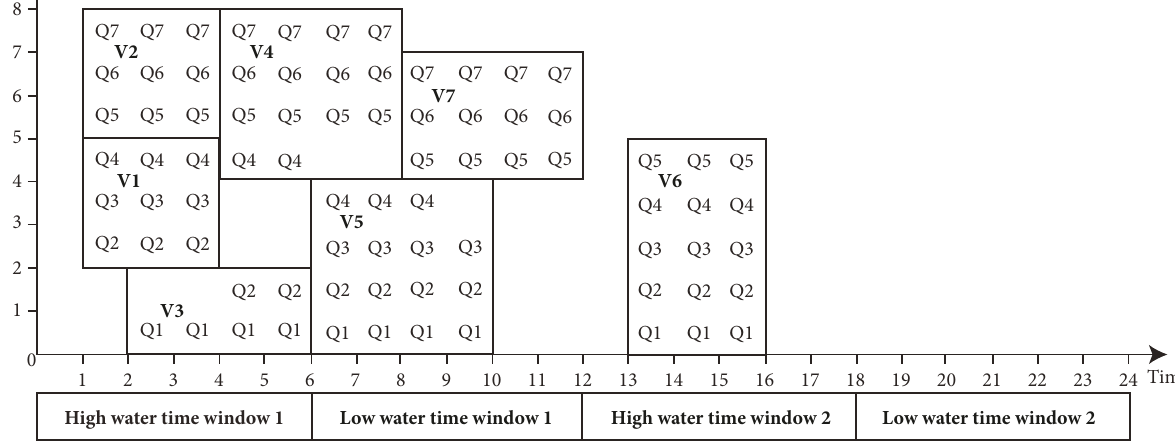
Figure 2: An optimal solution of a BACASP-TC